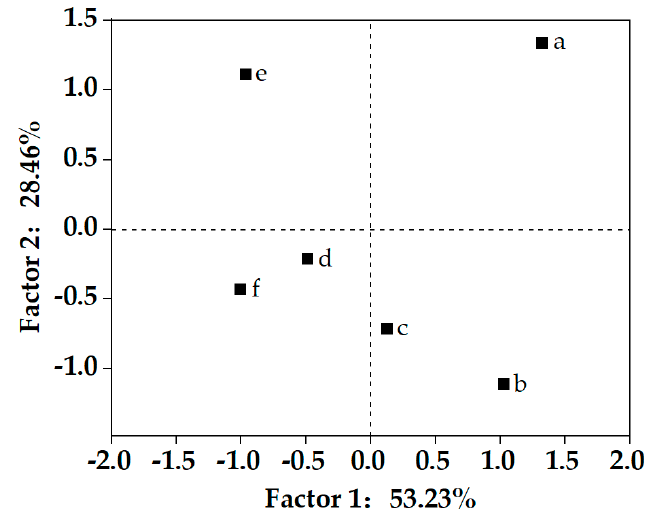
Figure 4. Principal component analysis (PCA) of Chinese steamed bread with different sourdough fermentation times: (a) 4 h; (b) 8 h; (c) 12 h; (d) 16 h; (e) 20 h; (f) 24 h.